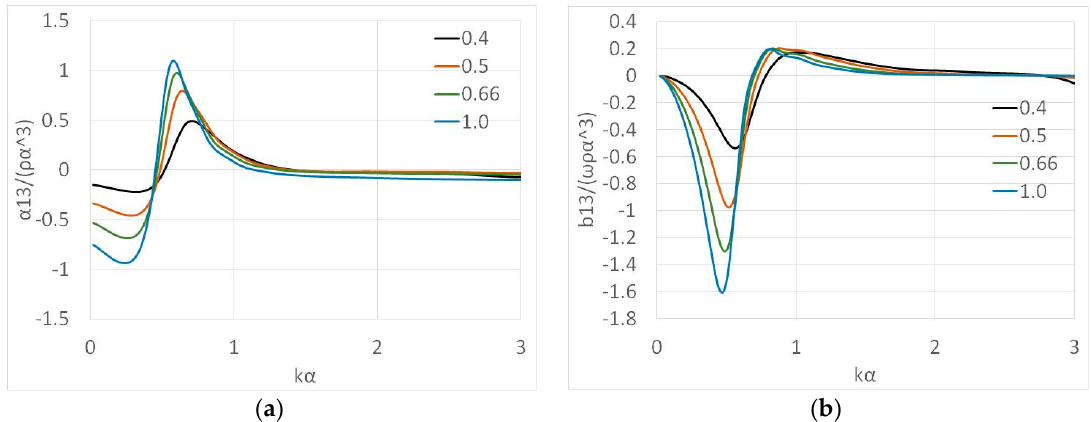
Figure 8. Hydrodynamic coefficients of a floating cylindrical floater placed in front of an orthogonally shaped (right angle) breakwater using the method of images for a /h = 0.4; 0.5; 0.66; 1.0: ( a ) heave added mass due to motion of the floater in heave ( b ) heave damping due to motion of the floater in heave.